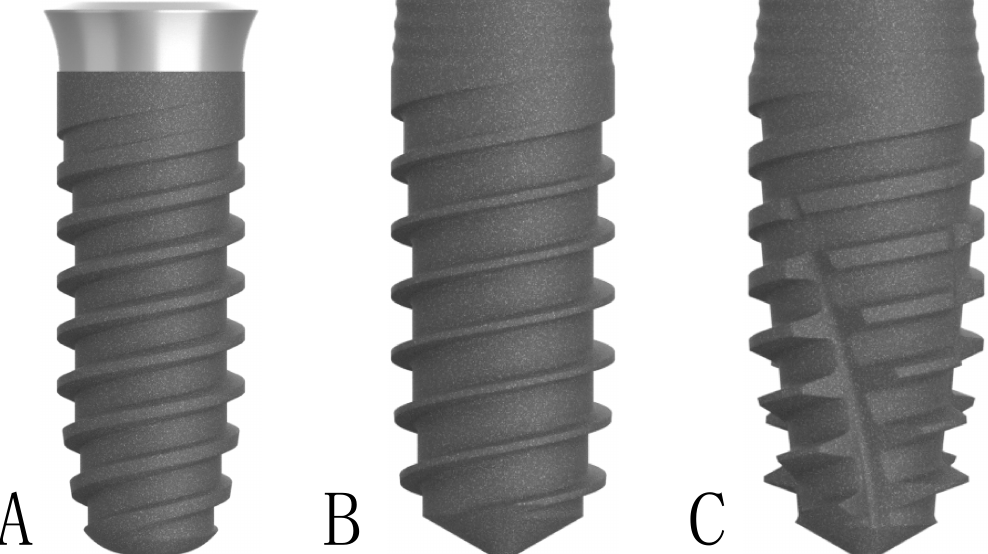
Figure 1. Implant designs evaluated in the study: Essential Cone ® ( A ), Vega ® ( B ), and Vega+ ® ( C ). On them, the connection of an abutment for elaboration of a 6 mm height cemented prosthesis was considered, according to the design suggested and commercialized by the manufacturer. A crown was placed on the aforementioned abutment that reproduced a first upper premolar with an inclination of its cusps of 6°. The cement layer between the crown and abutment was ignored, assuming a precise passive fit and an effective joining of the two components. The implants were placed at the recommended levels with respect to the bone crest. loading protocol simulated an intimately connected bone–implant interface (osseointegration simulation, delayed loading protocol).